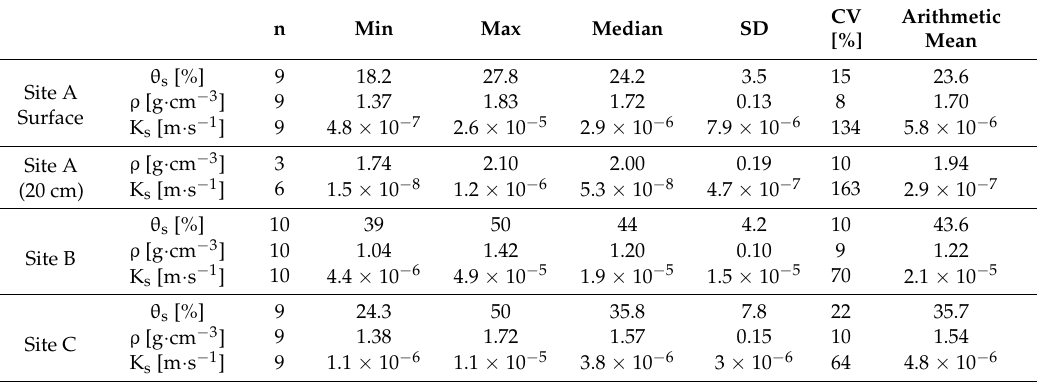
Table 2. Statistics of the measured saturated water content θ s , bulk density ρ , and saturated hydraulic conductivity K s for the three sites.